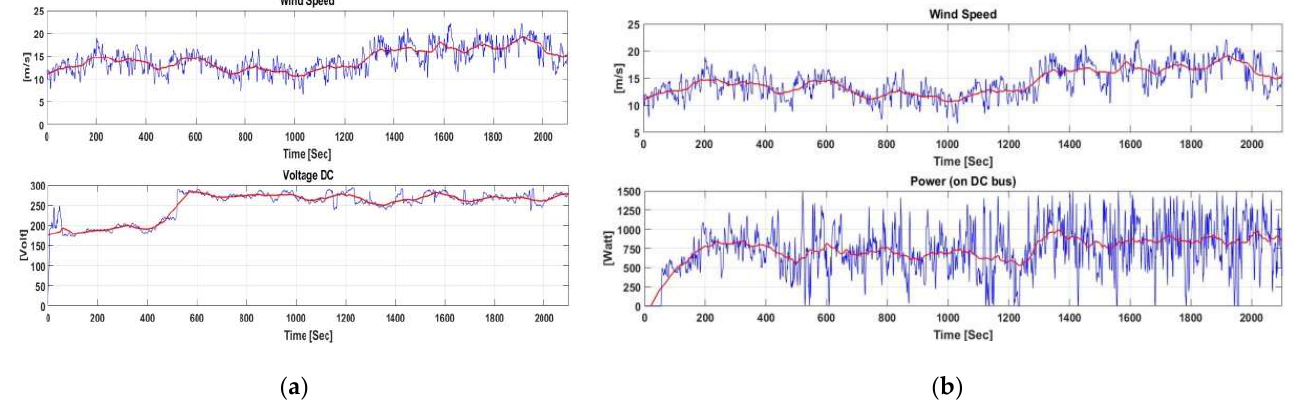
Figure 19. ( a ) Wind speed ( upper ) and DC voltage ( lower ), instant (blue) and averaged (red) values, as a function of time; ( b ) wind speed (blue) and DC power (red) as a function of time.